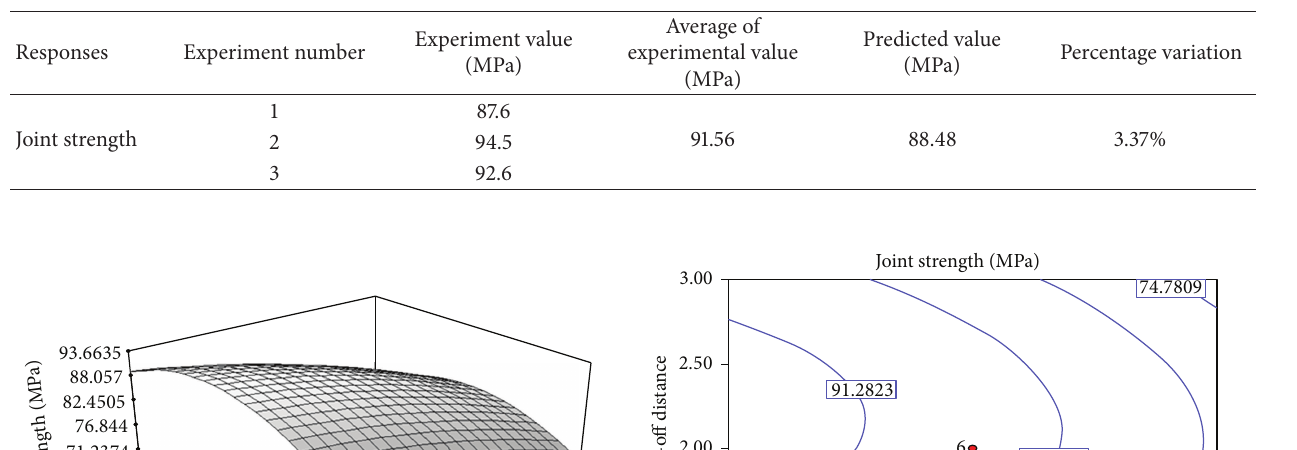
Table 5: Confirmation experiment table.